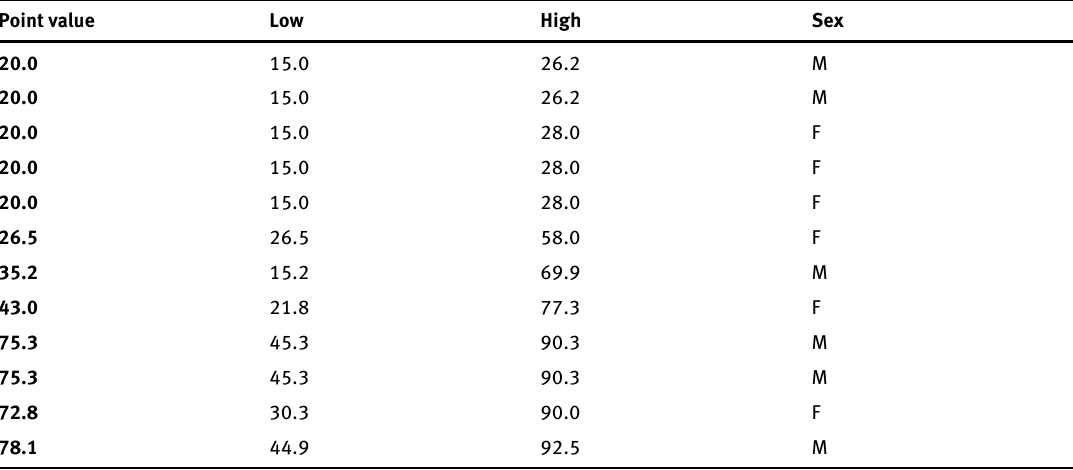
Figure 5. Adult age-at-death distribution divided by sex, based on the degeneration of the auricular facet as suggested by Lovejoy et al. (1985). Table 2. Age-at-death distribution using Transition